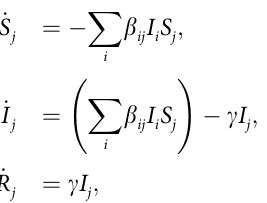
Fig 1. The time-evolution of S , I and R for epidemics with no control. A: R in both. Horizontal and vertical dashed black lines indicate the peak prevalence I max and average time of infection � t respectively, while green dashed horizontal lines show the attack rate R ( 1 ) found by numerically solving R ð1Þ ¼ 1 (cid:0) S ð 0 Þ e (cid:0) R 0 R ð1Þ .